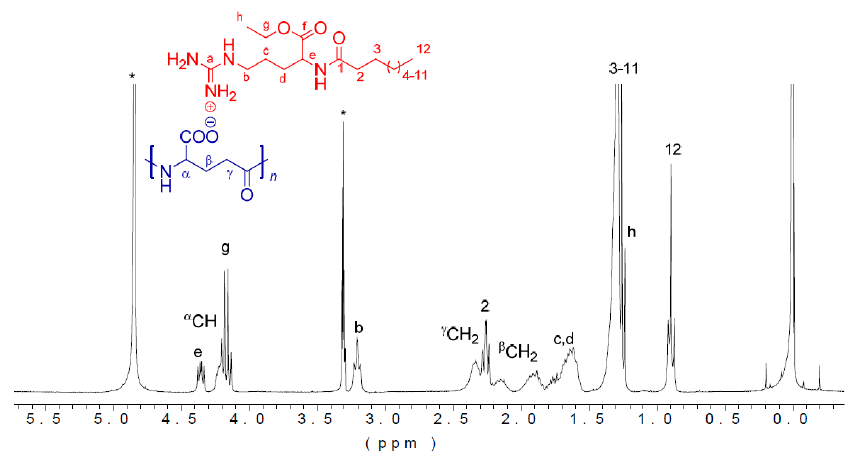
Figure 2. 1 H NMR spectra of LAE·PGGA-1 recorded at 25 °C in MeOD. *Asterisked signals are those arising from water and non-deuterated solvent.